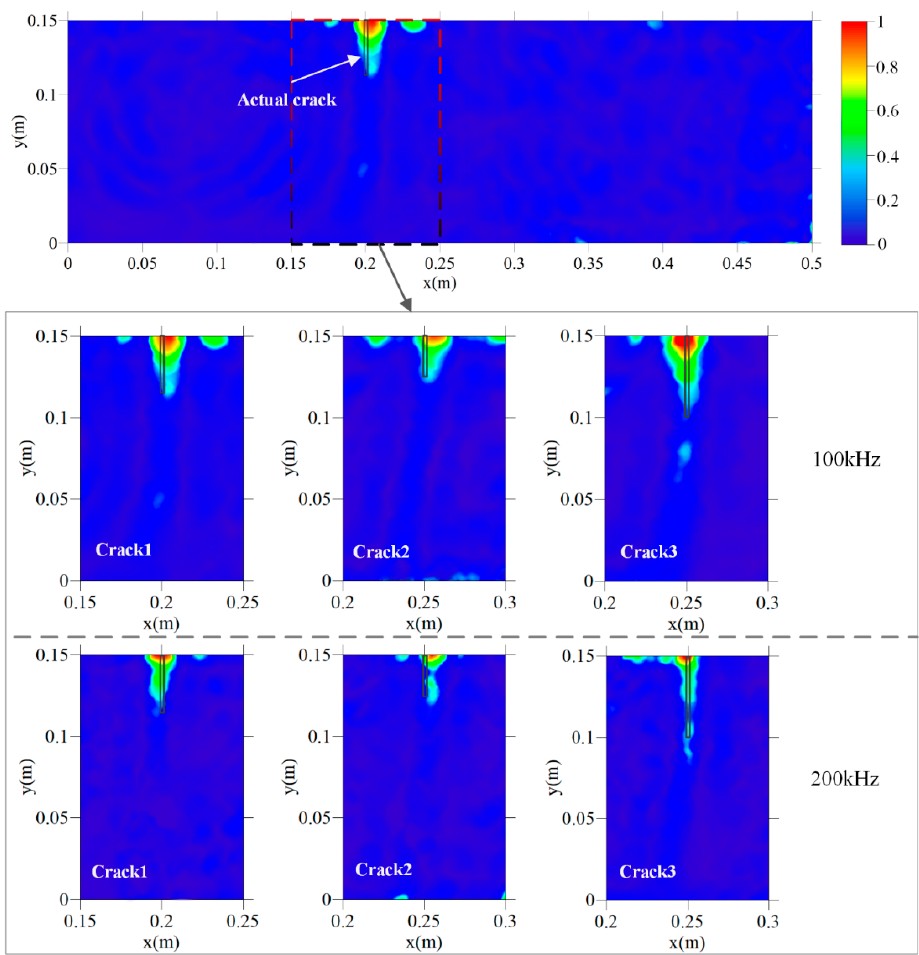
Figure 12. Imaging results of the underwater crack by FE simulation based on ˆ E avg ( x ) at the dominating frequencies of 100 and 200 kHz. Table 3. Quantitative identification results of the